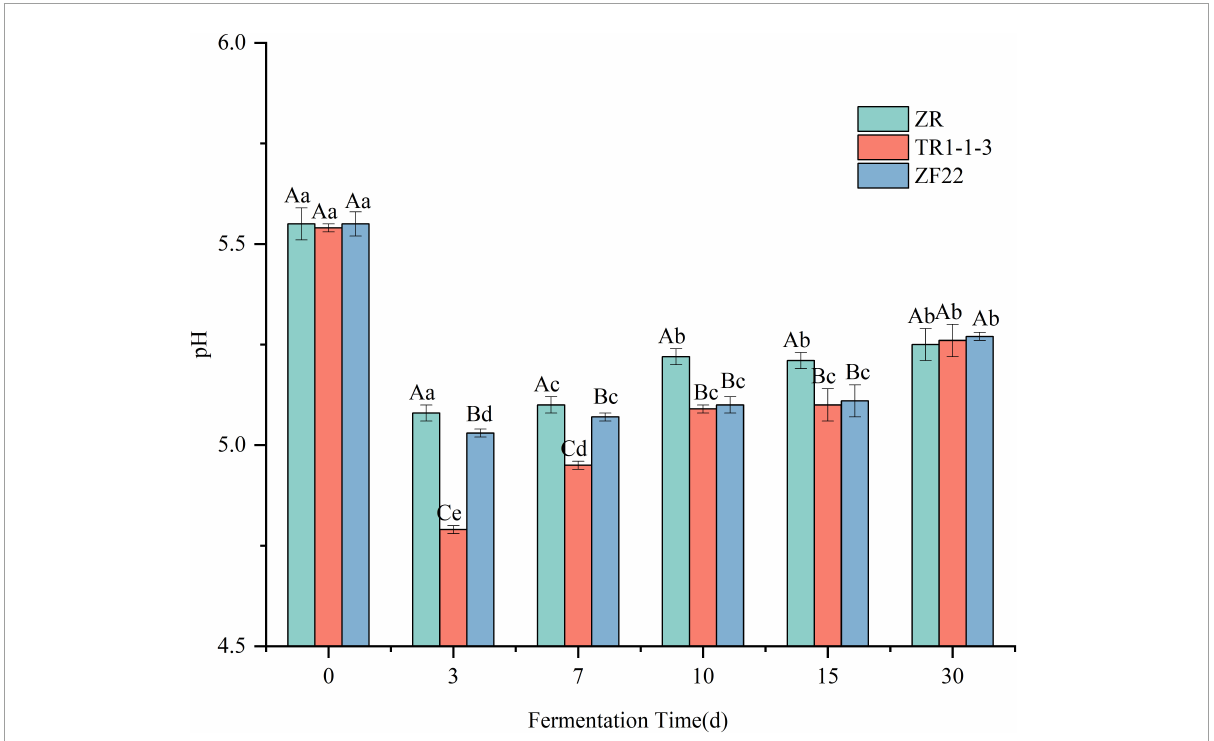
FIGURE1 Evolution of pH value in sausages non-inoculated and inoculated with both lactic acid bacteria during fermentation and storage from 0 to 30 days. Error bars refer to the standard deviations obtained from triplicate sample analysis. Uppercase indicates the same condition, and the difference between different samples is statistically significant ( p < 0.05). Lowercase letters indicate significant differences under different conditions in the same sample ( p <